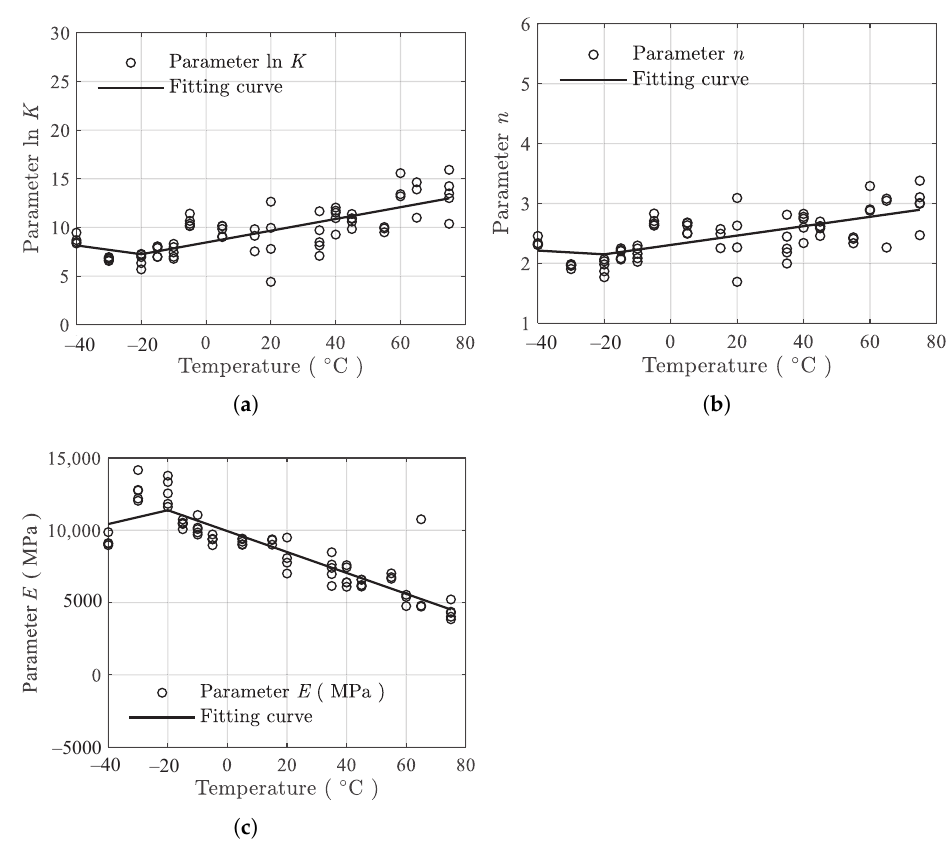
Figure 8. Mean fit of the temperature dependence data under tension. ( a ) ln K , ( b ) n , and ( c ) E . Substituting Equation (3) into Equation (2) with parameters in Equation (5), the